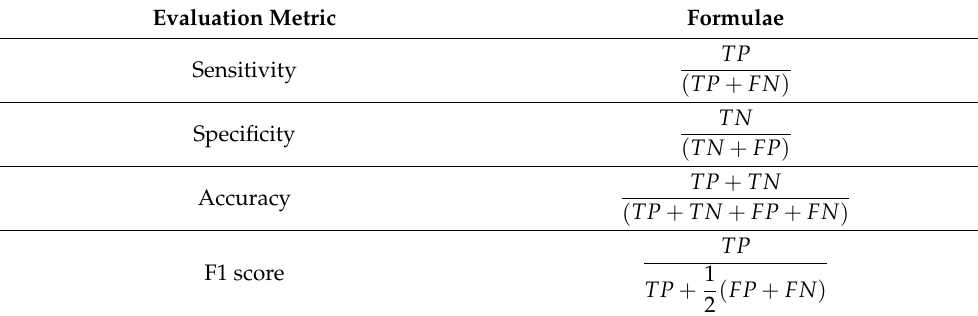
Table 4. Evaluation metric